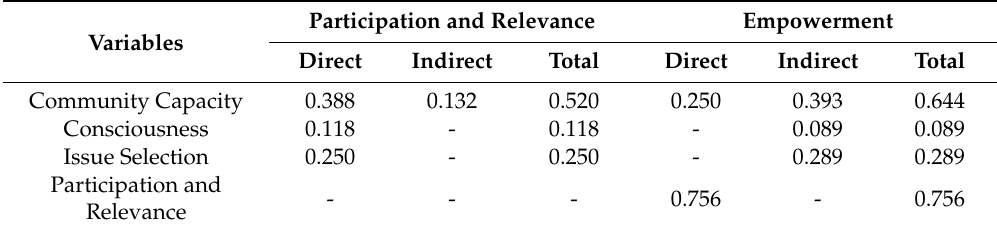
Table 4. Direct e ff ect, indirect e ff ect, and total e ff